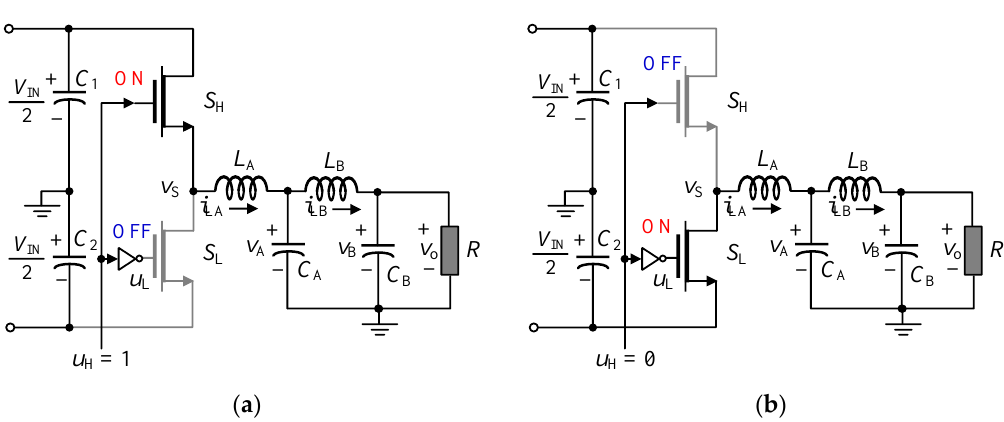
Figure 1. Equivalent circuits of fourth-order GaN class-D amplifier when ( a ) u H = 1 ( b ) u H = 0.